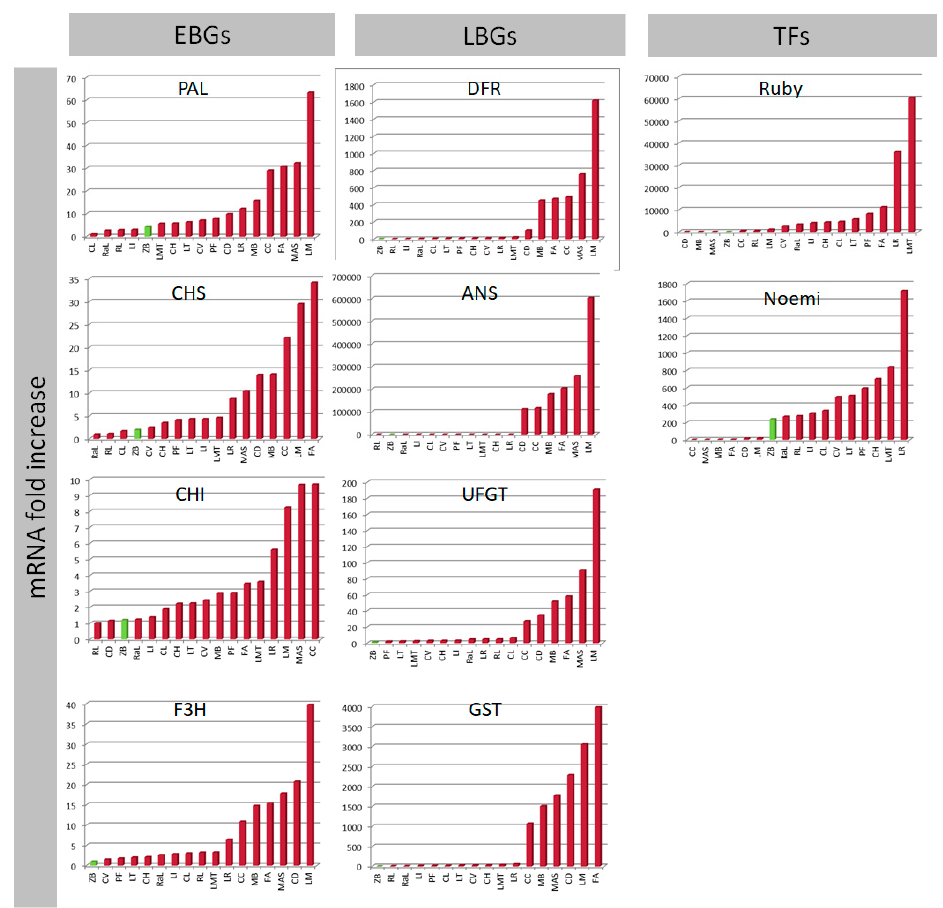
Figure 2. qRT-PCR expression data for all structural Early Biosynthetic Genes (EBGs) and Late Biosynthetic Genes (LBGs) and Transcription Factors (TFs) separated from young leaves. The expression levels were calculated as the mRNA fold increase. Each accession is indicated by a code: ‘Zagara bianca’—ZB, ‘Red lime’—RL, ‘Rangpur lime’—RaL, ‘Incomparabile’—LI, ‘Pink fleshed’—PF,